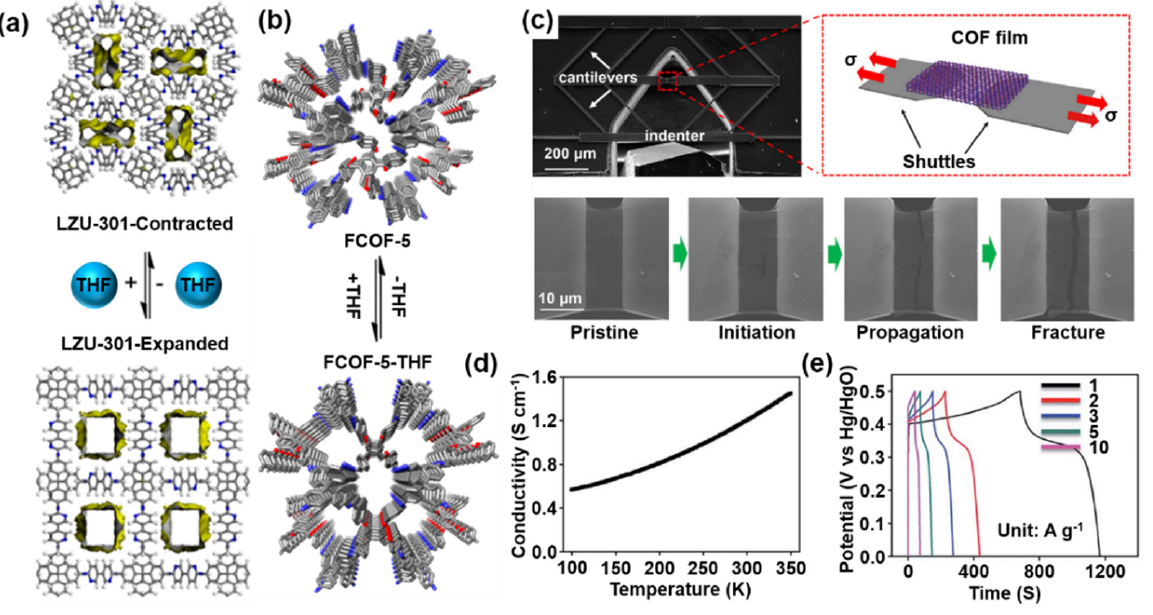
Figure 8. Optimization of dynamic structure, mechanical properties, and electrochemical activity for MEES devices. ( a ) Schematic illustration of the transformation into the expanded structure presented in LZU–301 [119]. Copyright 2017, American Chemical Society. ( b ) Reversible crystal struc- tures transformation between FCOF–5 and FCOF–5–THF [121]. Copyright 2021, American Chemical Society. ( c ) SEM image and schematic for uniaxial tension of nano-mechanical devices (above). In situ tensile snapshots of the COF film with the whole process of crack propagation (below) [120]. Copyright 2021, Elsevier Inc. ( d ) Variable-temperature van der Pauw conductivity measurement. ( e ) GCD curves at different current densities (1–10 A g − 1 ) [122]. Copyright 2019, The Royal Society of Chemistry.